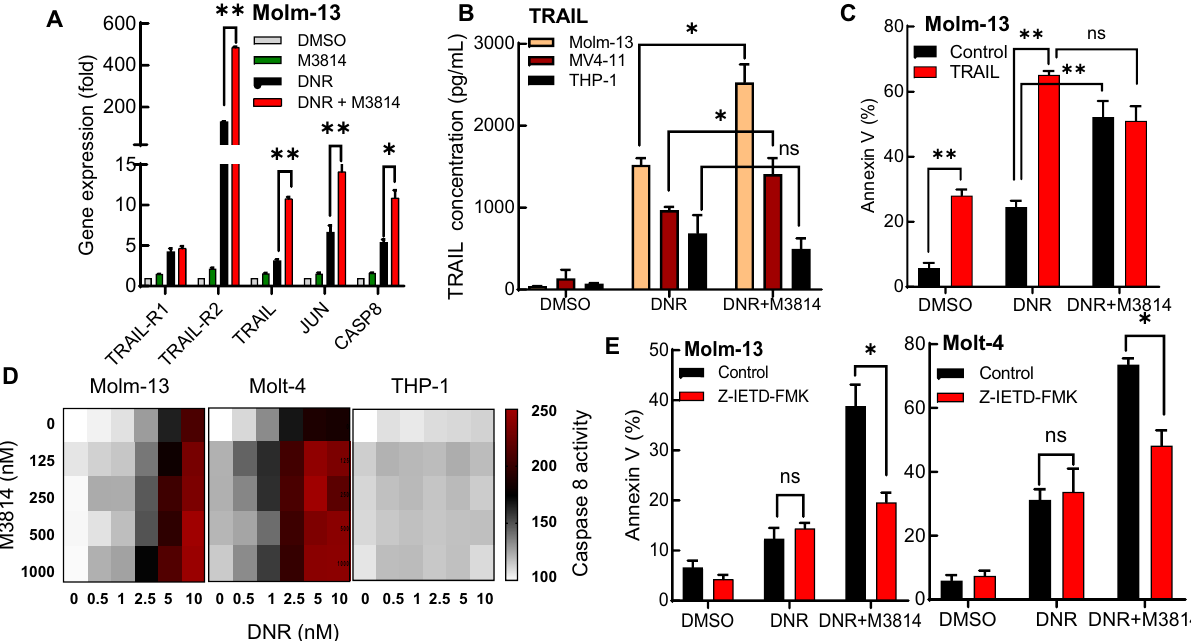
Figure 4. DNR/M3814 combination drives TRAIL-dependent extrinsic apoptosis in leukemia cells. ( A ) Molm-13 cells were pretreated with M3814 (300 nM) or vehicle for 45 min before treatment with 10 nM daunorubicin. RNA was isolated 24-h post-treatment and the expression of TRAIL-R1, TRAIL-R2, TRAIL, JUN, and CASP8 was analyzed by qPCR. Gene expression was normalized to GAPDH. ( B ) Molm-13, MV4- 11 and THP-1 cells were treated as described in A. Media from each condition was isolated and assayed by Human TRAIL ELISA. Concentration of TRAIL in medium was determined by a standard curve. ( C ) Molm-13 cells were pre-treated with M3814 (300 nM) or vehicle. Cells were then treated with DMSO or daunorubicin (1 nM) in the presence or absence of TRAIL (50 ng/ml). Apoptosis was assessed 24-h post-treatment by flow cytometry using PE-conjugated annexin V. ( D ) Molm-13, Molt-4 and THP-1 cells were pre-treated with increasing concentrations of M3814 for 45 min. Cells were then treated with DNR in the concentration range 0–10 nM. Caspase-8 activity was measured 6 h post-treatment using the CaspaseGlo-8 Assay and presented as relative luminescence. ( E ) Molm-13 and Molt-4 cells were pre-treated with M3814 (300 nM) or vehicle in the presence or absence of Z-IETD-FAK (10 µM) for 45 min. Cells were then treated with DNR (1 nM). Apoptosis was assessed 24-h post-treatment by flow cytometry using PE-conjugated annexin V. *p < 0.05, **p < 0.01, ***p < 0.001. NS: p >